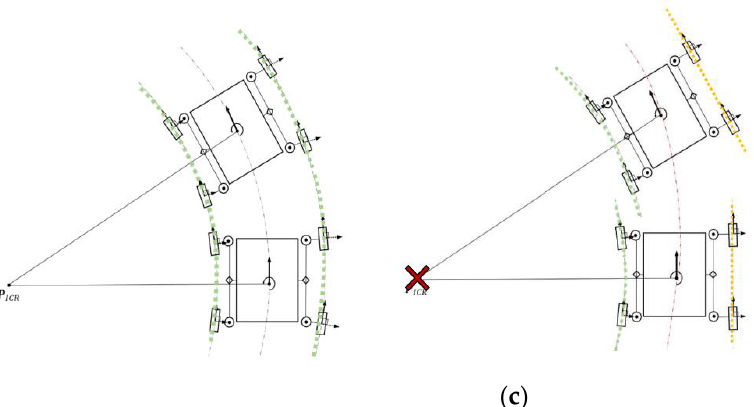
Figure 2. Driving and steering mechanisms of the 4-wheeled 2-steering lunar rover. ( a ) The dual- motor driving system with hardware redundancy. ( b ) The modified explicit-steering system, which requires software-level backup solutions. ( c ) Moving pattern of the rover with increased uncertainty in steering control due to a failure in the right steering motor.